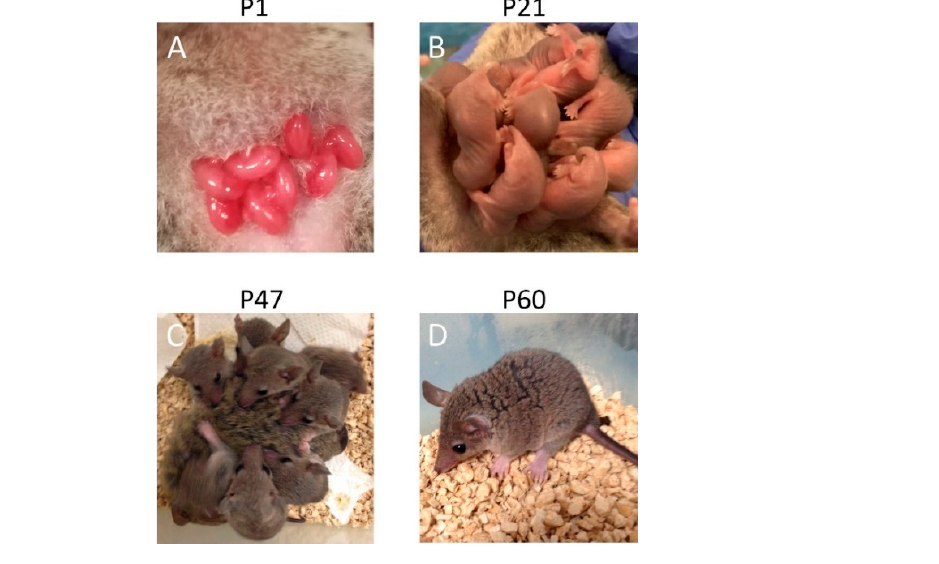
Figure 1. Opossums ( Monodelphis domestica ) at different ages. In ( A ), newborn opossums attached to the mother’s nipples. In ( B , C ), opossums at the age of 21 and 47 days remain with the mother. In ( D ), the opossum at weaning (day 60) is sexually immature. P, postnatal day.